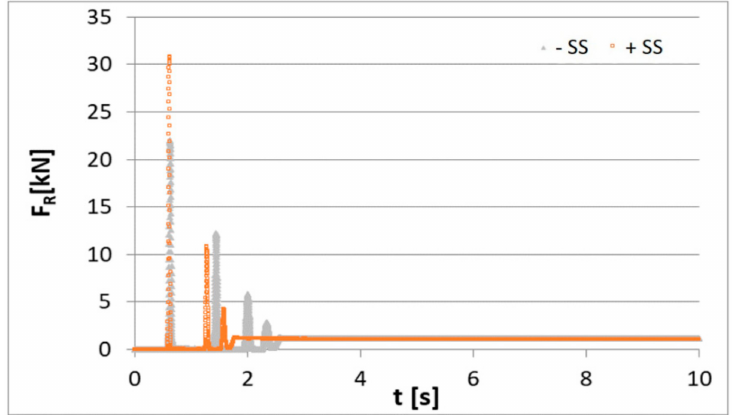
Figure 8. Correlation between the impact force F R and time t, with and without using the support system